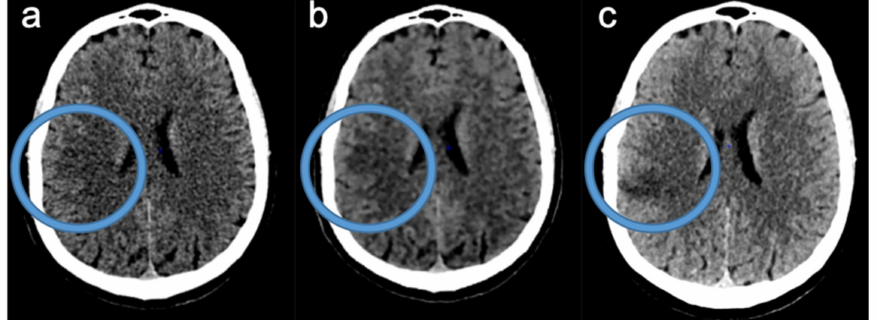
Figure 5. Illustrative case with a difference between ASPECTS with FIRST-LCD and AIDR3D. ( a ): NCCT with AIDR3D; ( b ): NCCT with FIRST-LCD with the same windowing); ( c ): NCCT follow-up imaging. Example of an acute ischemic stroke in the right cerebral arterial territory detected on ( b ) with ASPECT 9/10, whereas ( a ) was scored ASPECT 10/10. ( c ) Confirms the acute ischemic